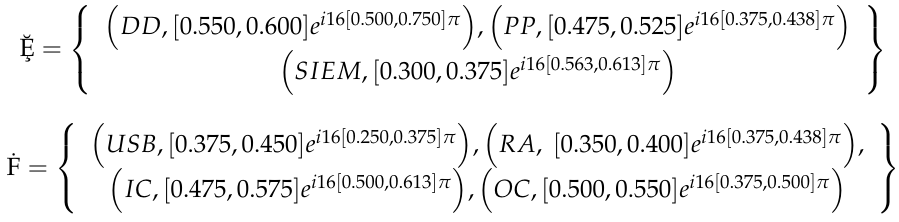
Table 4 contains the details of abbreviations used in the above sets. Table 4.